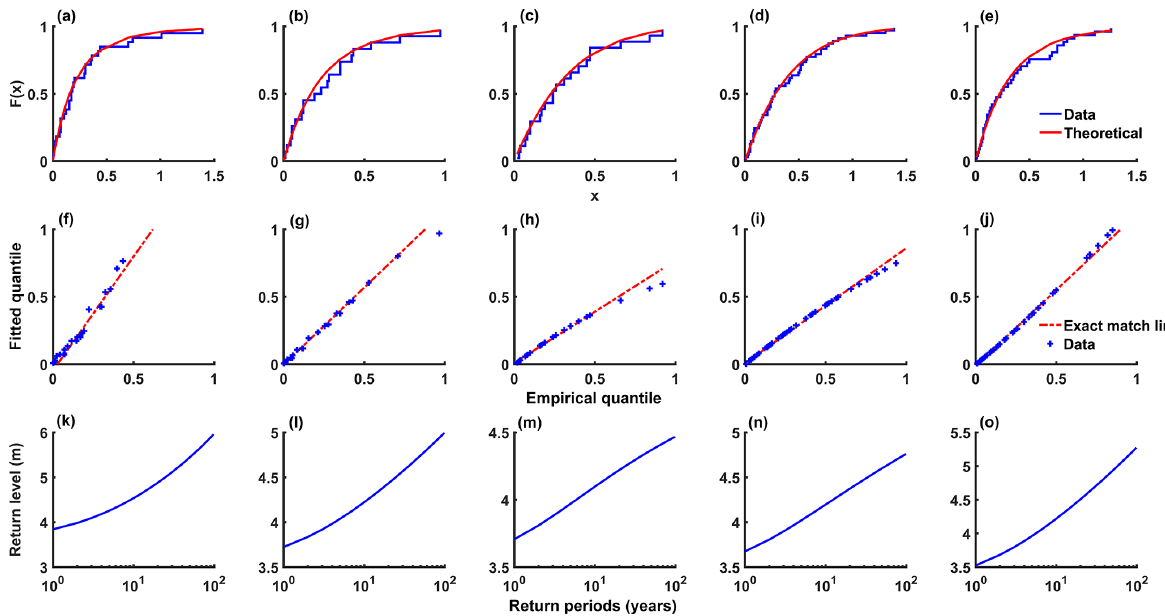
Figure 4. Figure corresponding to the full-year analysis. (a) to (e) represent the CDF plots for half, 3, 6, 12 and 24-hourly data respectively; (f) to (j) correspond to Q - Q plots; (k) to (o) correspond to return levels estimated using the GPD model.